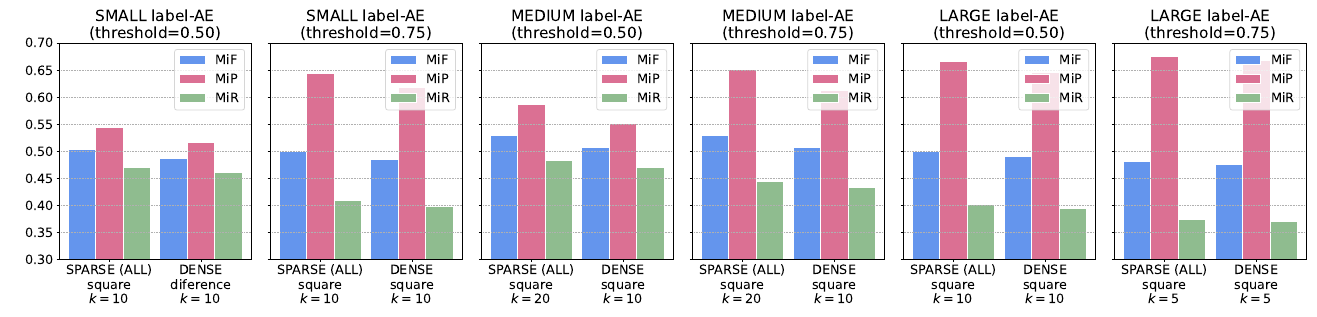
Figure 4. Summary of MiF , MiP , MiR metrics for values of k and distance weighting with best MiF values in each label-AE configuration ( SMALL , MEDIUM , LARGE